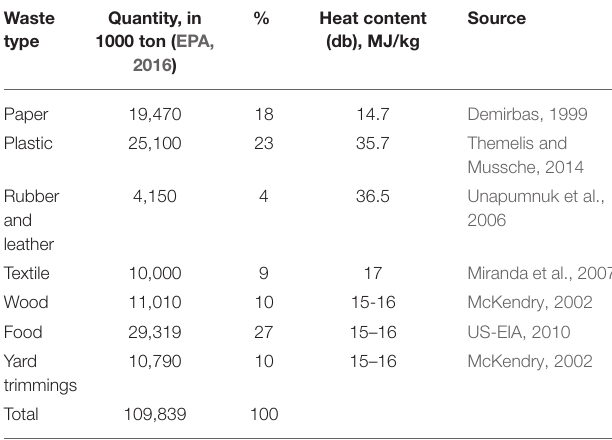
TABLE 1 | U.S. wastes, quantities, and heat